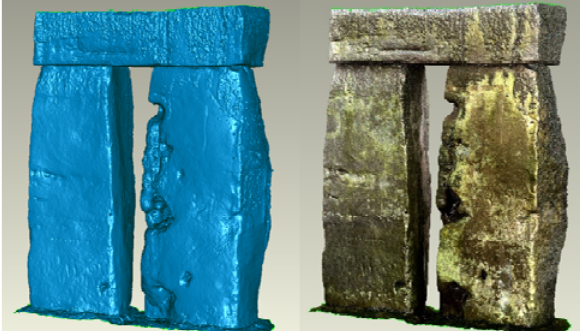
Figure 5 - Meshed 3D models for stones 53 & 54 with the addition of colourised point cloud data overlay